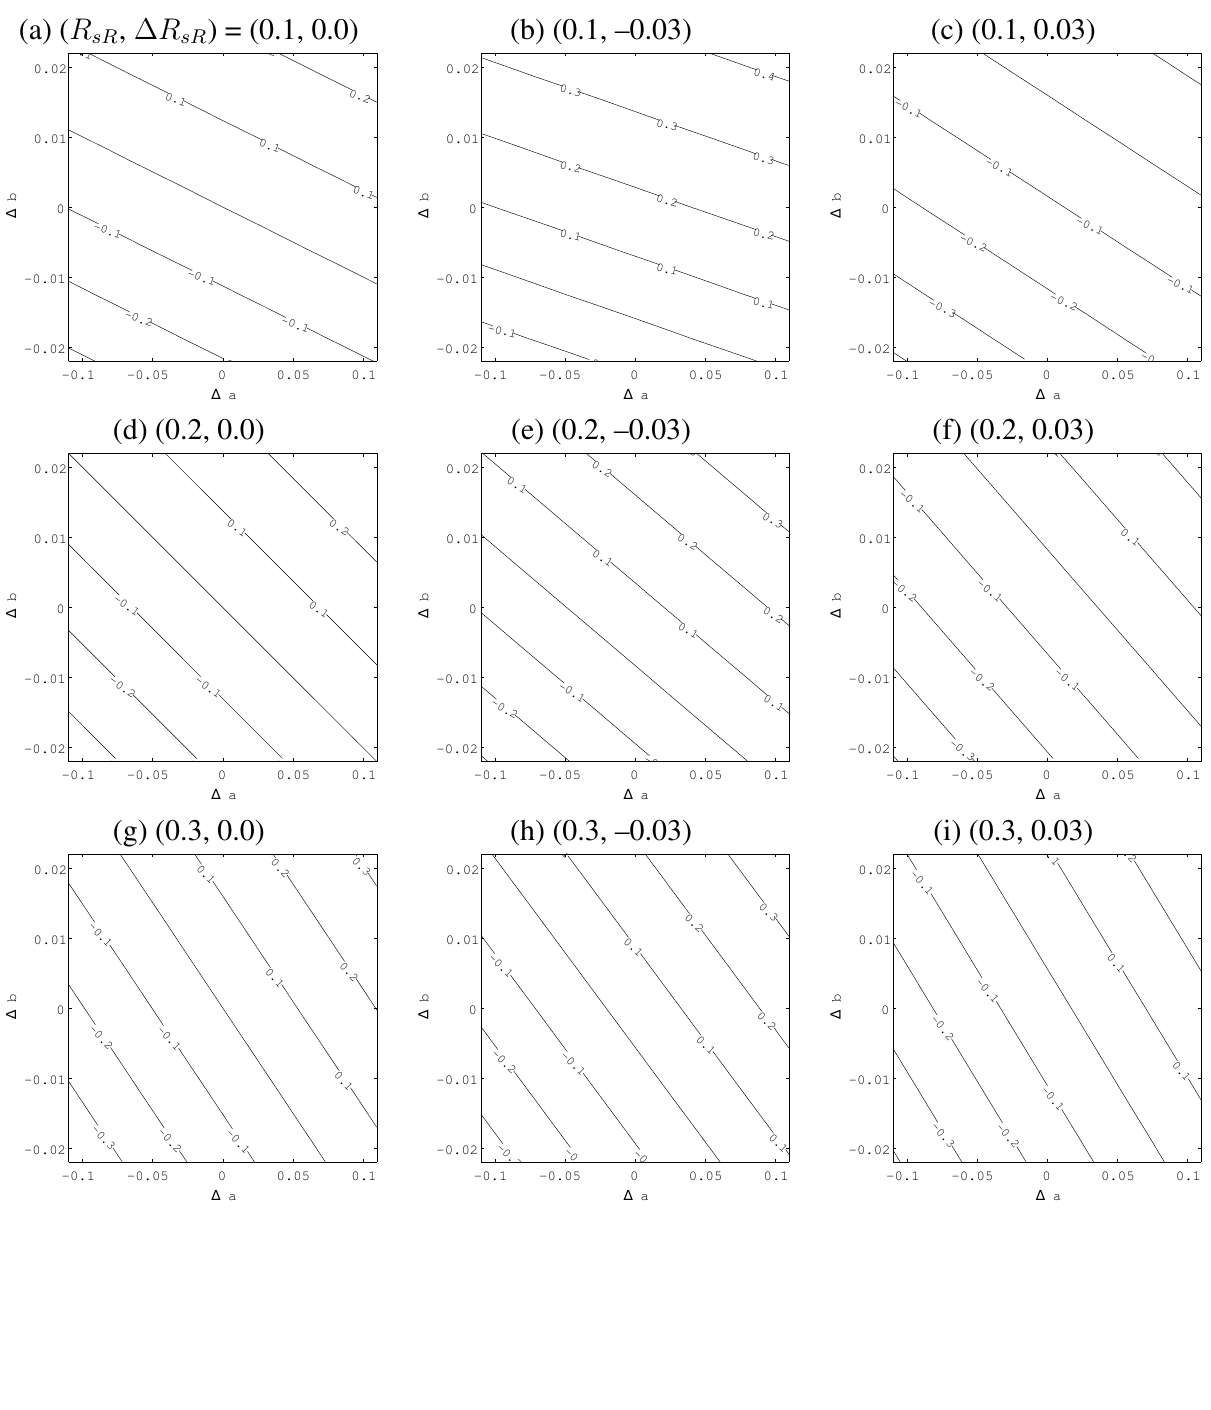
and ∆ R at (cid:12) = 1 : 0 and LAI = 0 : 25 sR sR